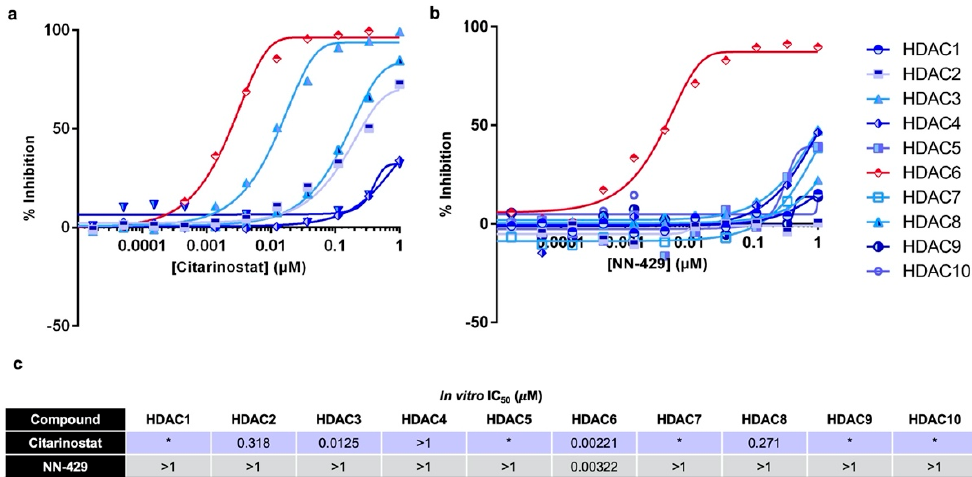
Figure 3. ( a ). Dose–response curves representing the percent inhibition of citarinostat against HDAC2, HDAC3, HDAC4, HDAC6 and HDAC8 via EMSA. ( b ). Dose–response curves representing the percent inhibition of NN-429 against HDAC1-10 via EMSA (Nanosyn, CA, USA). ( c ). In vitro HDAC inhibition IC 50 values of citarinostat and NN-429 against